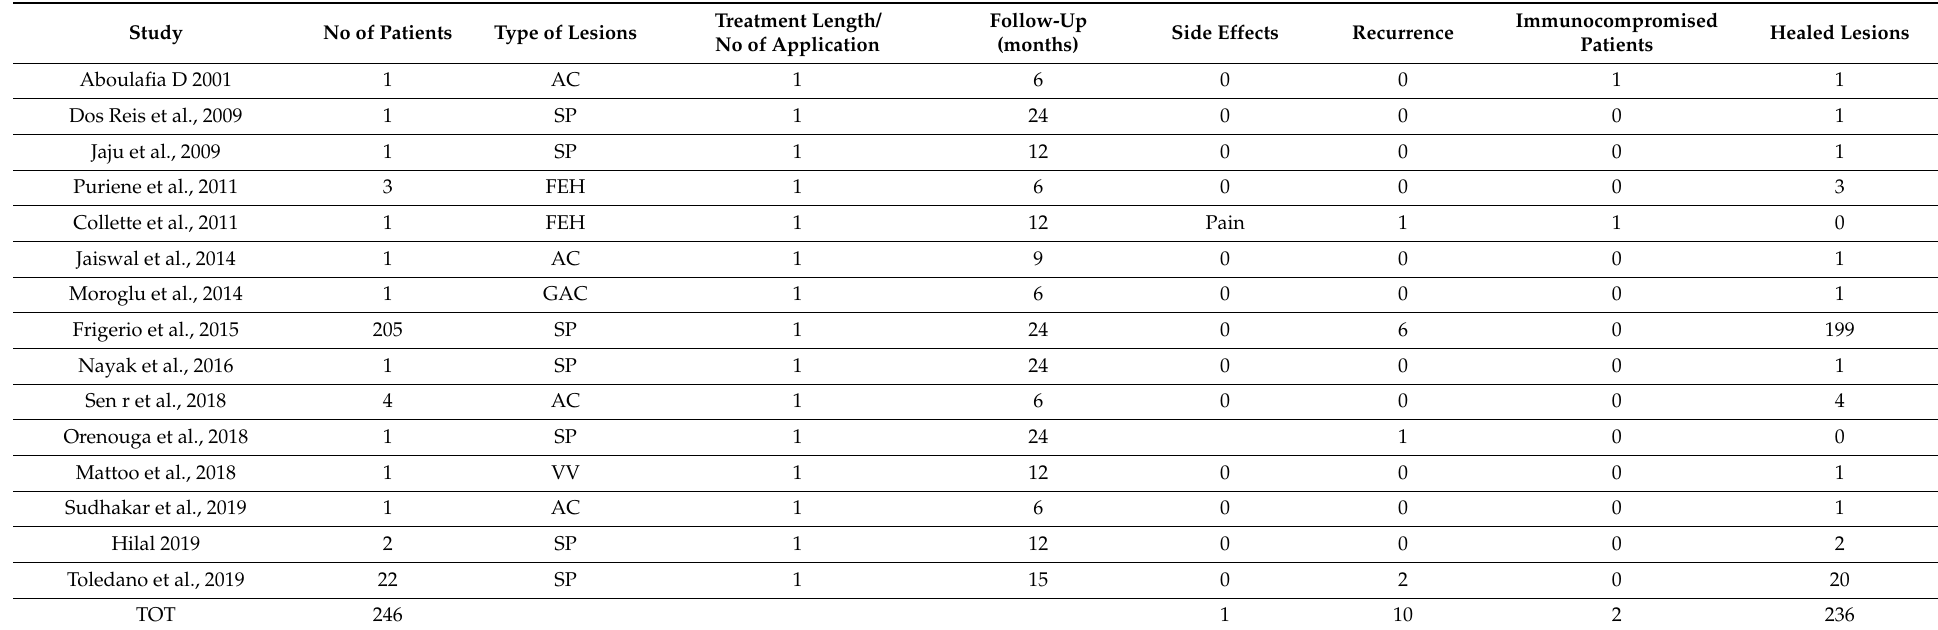
Table 12. Cold blade